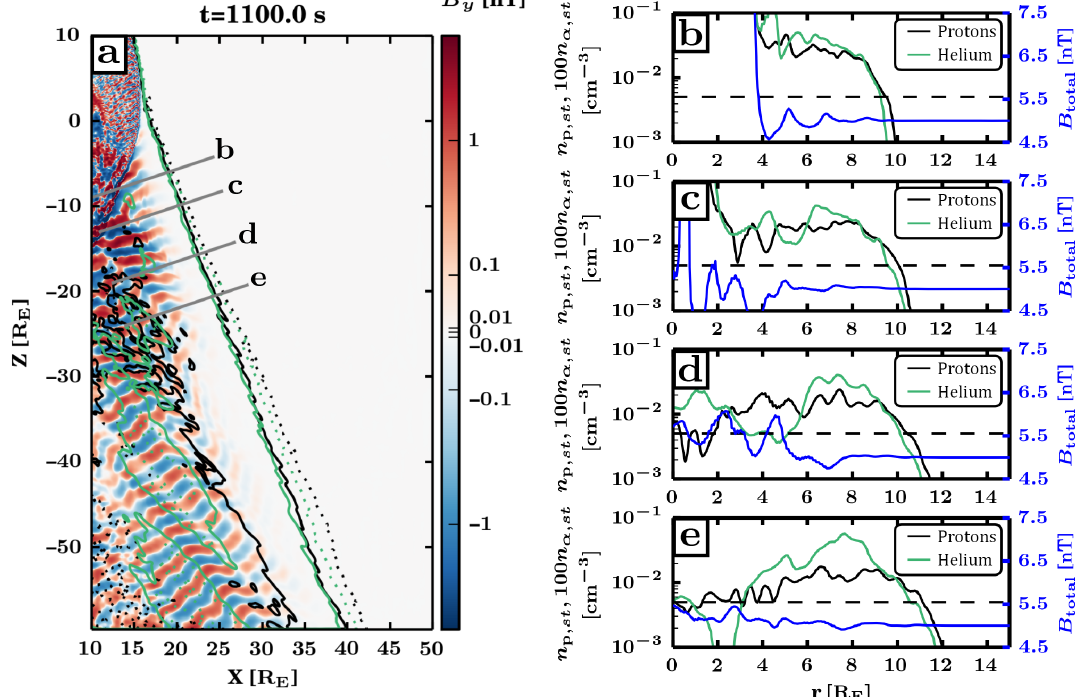
Figure 2. (a) Magnetic field out-of-plane component B y indicating the ULF foreshock extent. Contours indicate proton (black) and helium (green) suprathermal densities at 0.1% (dotted contours) and 0.5% (solid contours) of solar wind values. Four thick lines indicate the cut- throughs across the foreshock boundary. (b–e) Profiles across the foreshock at the positions shown in (a) . Profiles are shown for suprathermal proton density (black solid line), suprathermal helium density (green solid line), and magnetic field magnitude (blue solid line). The horizontal dashed lines indicate 0.5% (dashed line) of the solar wind